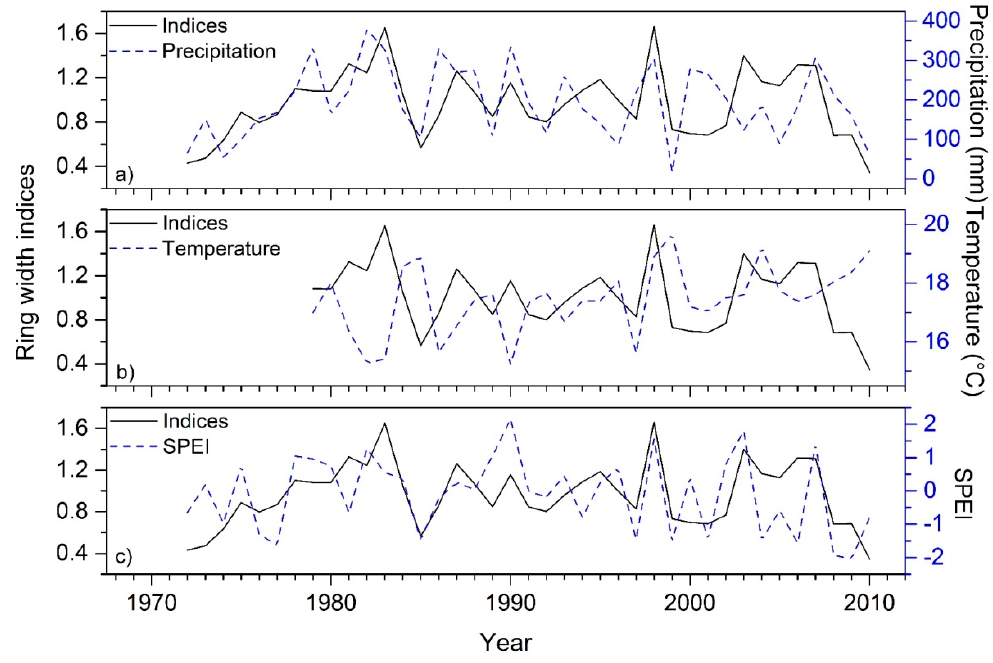
Figure 5. Comparison between ring-width indices of Chir pine and March-April precipitation (1972–2010) ( a ), temperature (1978–2010) ( b ) from meteorological records at Dadeldhura, and March Standardized Precipitation Evapotranspiration Index (SPEI) calculated at 5-month-long intervals (1972–2010) ( c ).